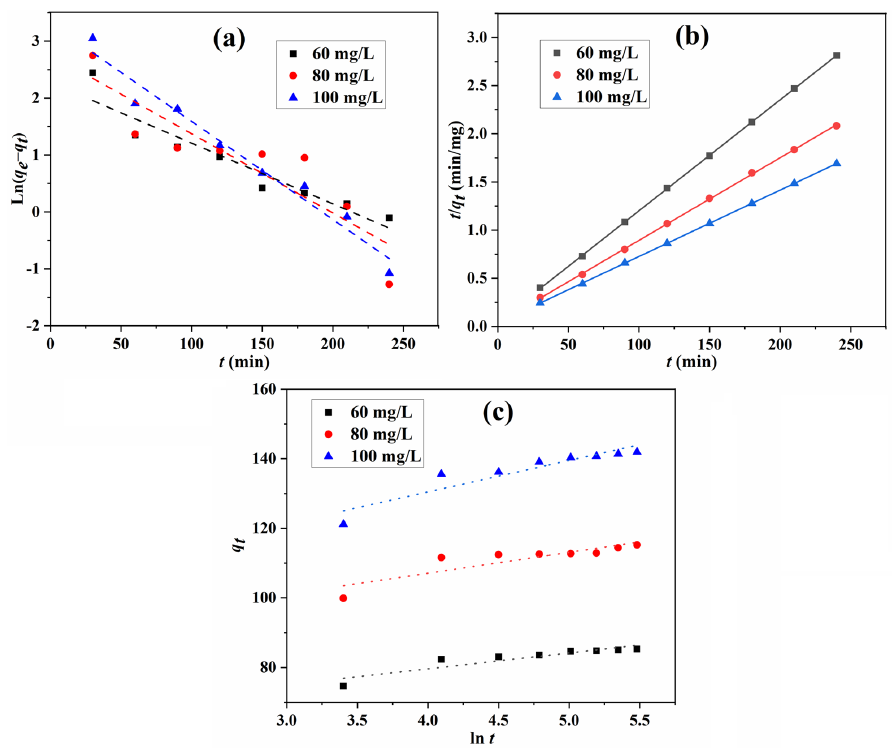
Figure 10. Fitting of pseudo-first-order ( a ), pseudo-second-order ( b ), and Elovich ( c ) kinetic models for the MB adsorption. Table 2. Kinetic parameters of three models for MB adsorption.